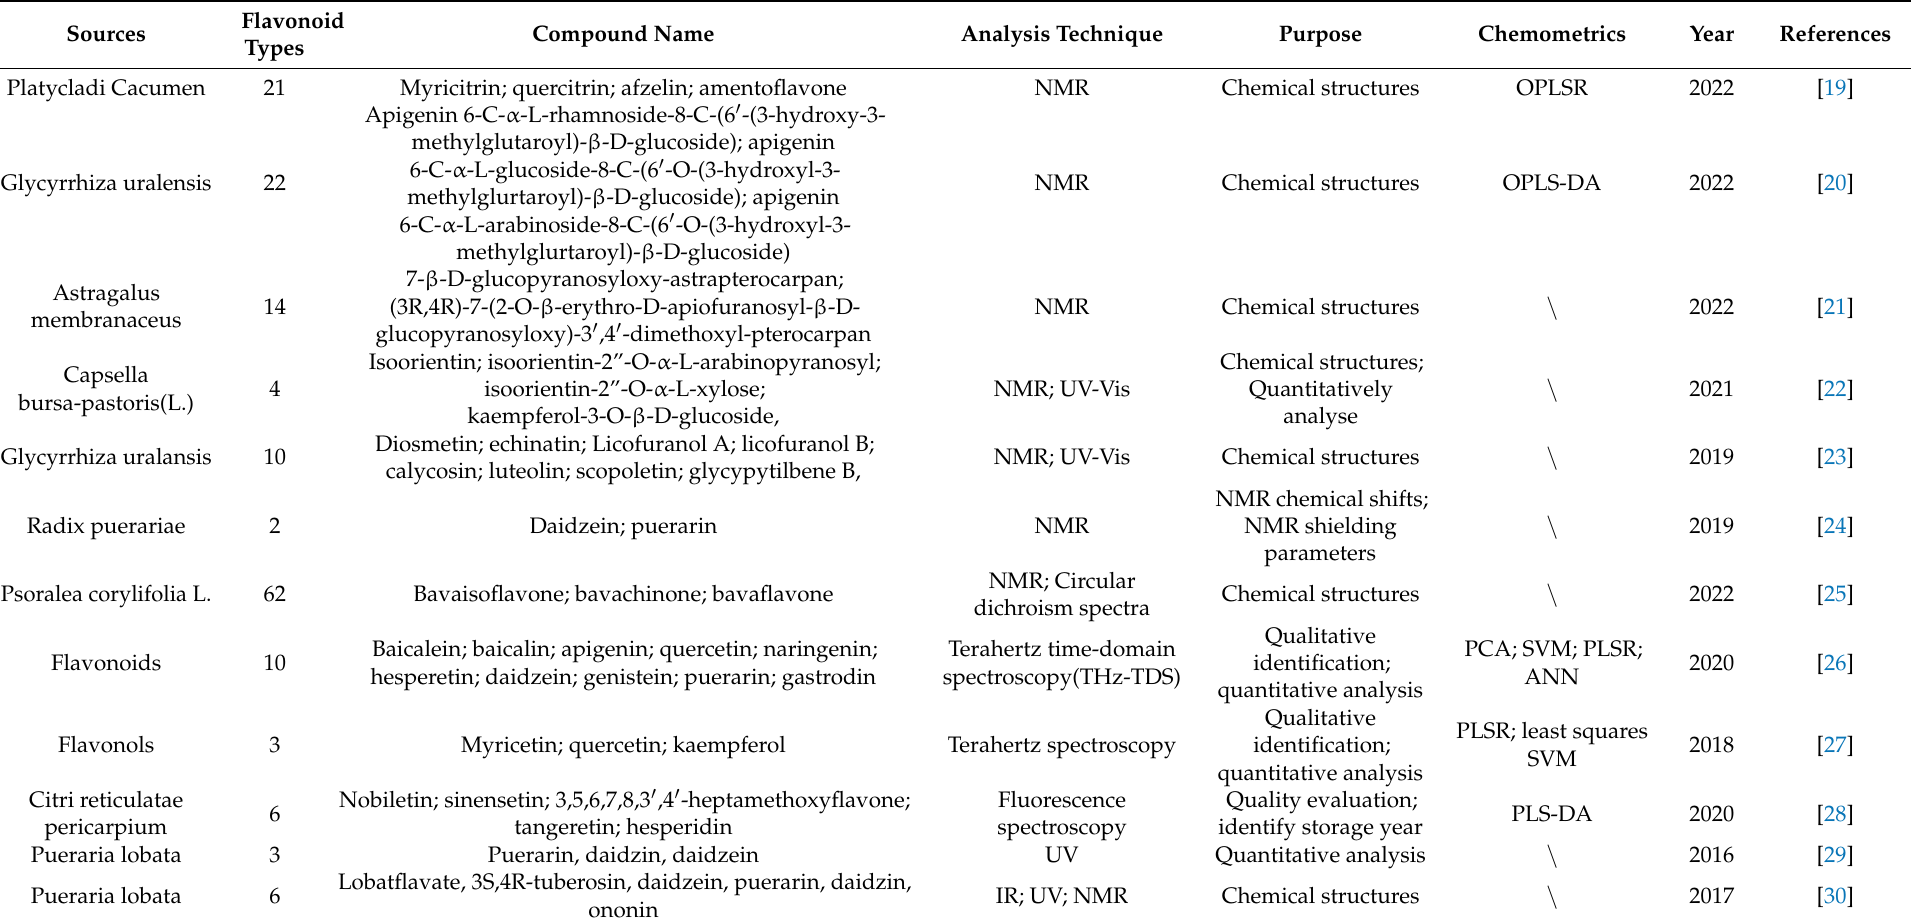
Table 1. Sources, flavonoid composition, spectroscopy techniques and chemometrics of medicinal and food homology